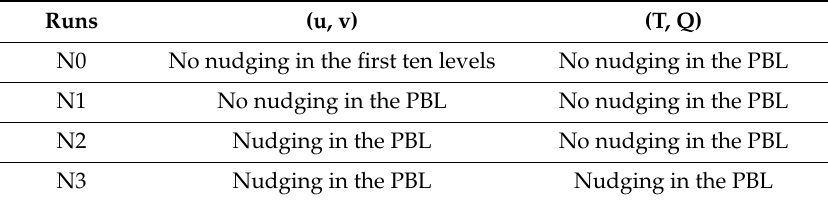
Table 2. Di ff erent arrangements of nudging parameters for (i) horizontal wind speed (u, v); (ii) temperature (T), and relative humidity (Q). Runs (u, v) (T, Q) N0 No nudging in the first ten levels No nudging in the PBL N1 No nudging in the PBL No nudging in the PBL N2 Nudging in the PBL No nudging in the PBL N3 Nudging in the PBL Nudging in the PBL PBL—planetary boundary